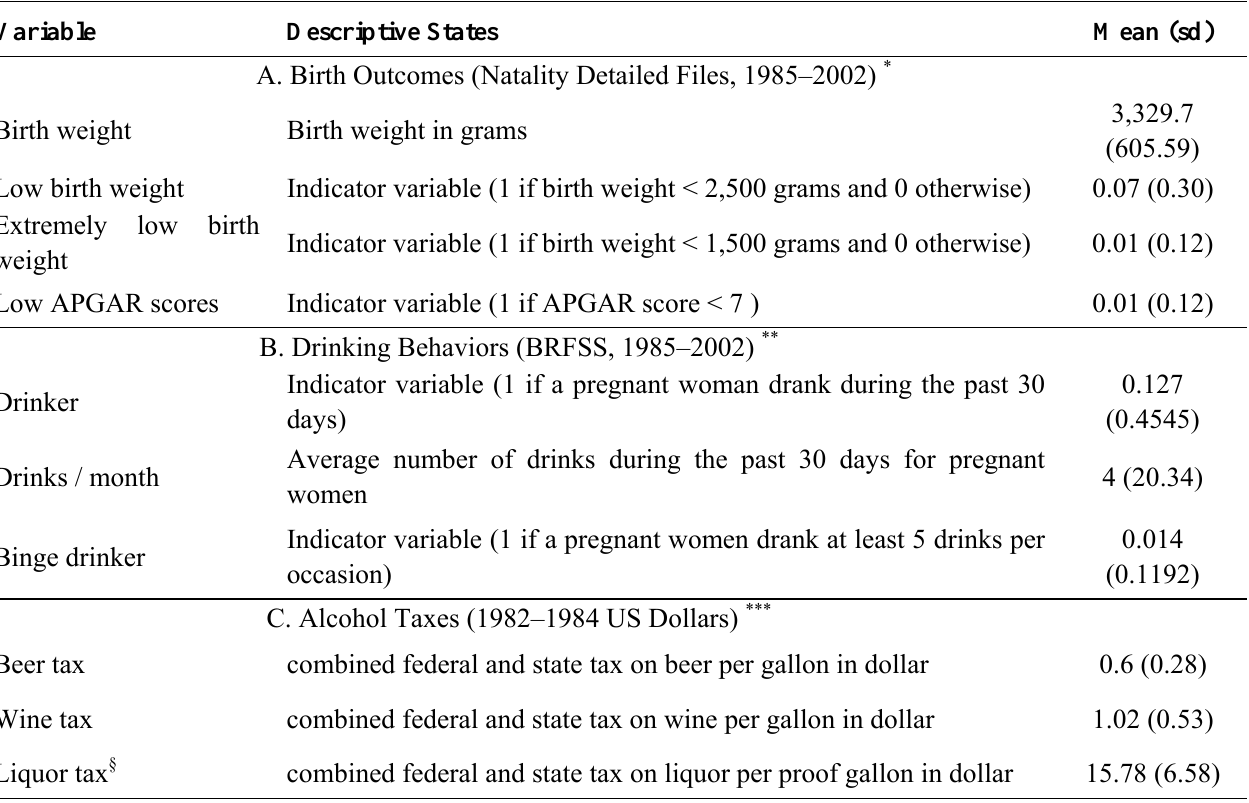
Table 1. Variables definition and descriptive